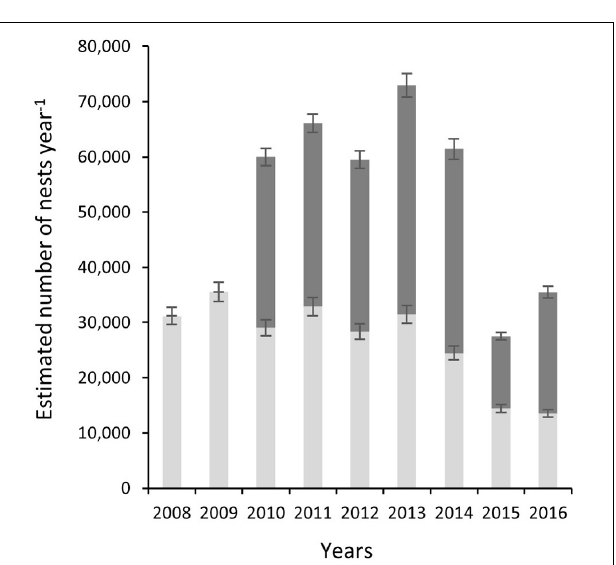
FIGURE 4 | Estimated number of nests per year (nests year − 1 ) for index beaches (K0–K22) as gray bars and non-index beaches (K23–K83) dark gray bars. Stacked results show total estimate for the rookery.